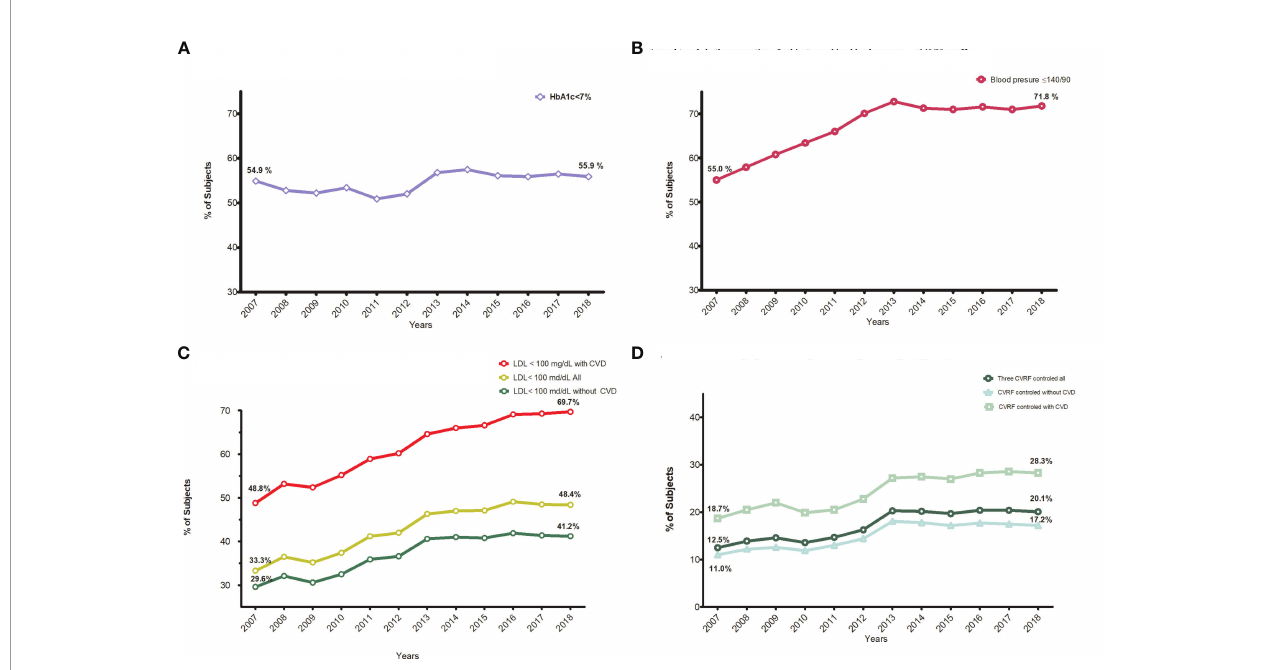
FIGURE 4 | Trends in the proportion of subjects achieving different therapeutic goals. (A) Annual trends in the proportion of subjects reaching HbA1c <7%. (B) Annual trends in the proportion of subjects reaching blood pressure ≤ 140/90 mmHg. (C) Annual trends in the proportion of subjects reaching LDL-C<100 mg/dl, global,with and without cardiovascular disease. (D) Annual trends in the proportion of subjects reaching all three goals, global, with and without cardiocvascular